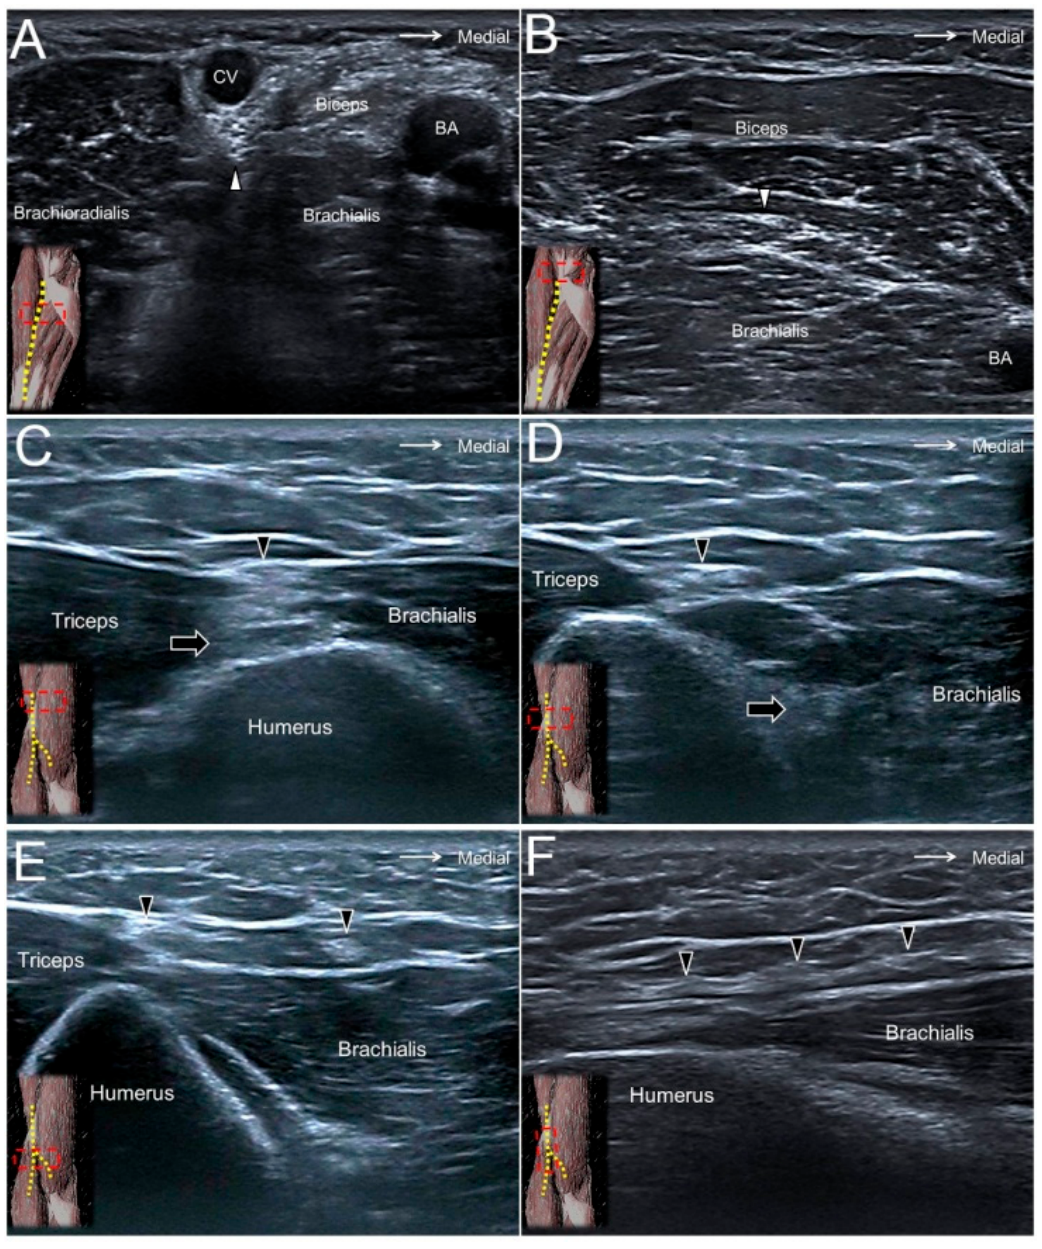
Figure 5. The lateral antebrachial cutaneous nerve (white arrowhead) at the elbow (A) and distal forearm (B) levels. The posterior antebrachial cutaneous nerve (black arrowhead) at the exit of the spiral groove (C) , the distal forearm (D) , and near the lateral epicondyle (E) . Long axis of the posterior antebrachial cutaneous nerve (F) . CV, cephalic vein; BA, brachial artery; black arrow, radial nerve.